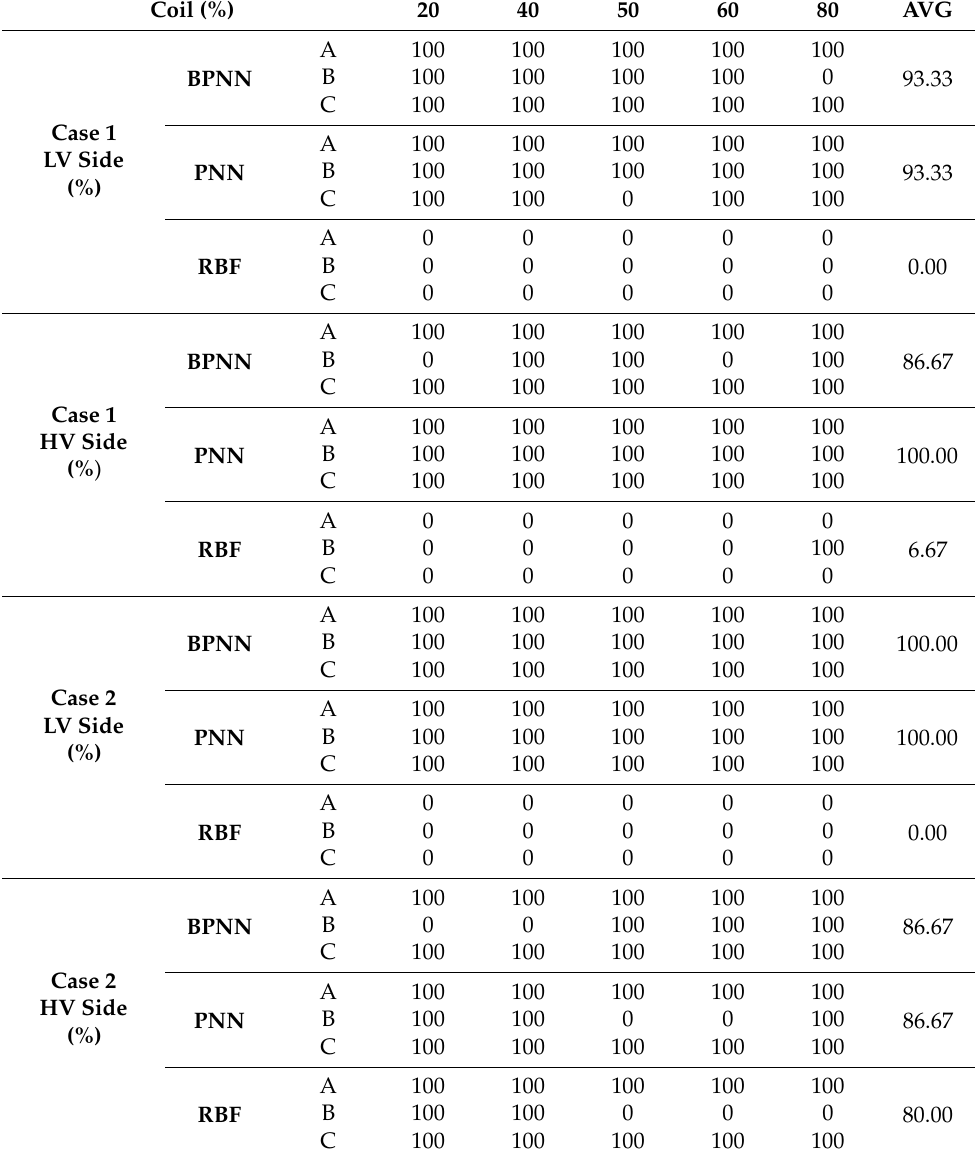
Table 5. Percentage of external winding fault